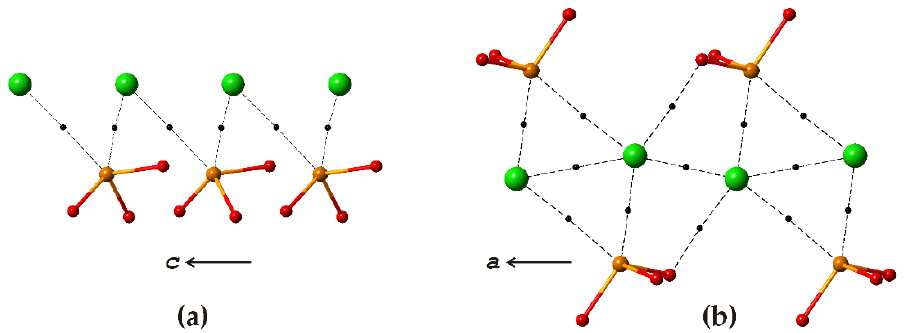
Figure 7. The arrangement of (SeO 3 ) groups and Cl atoms in the channels in the crystal structures of georgbokiite ( a ) and parageorgbokiite ( b ). Dashed lines indicate bond paths that correspond to weak closed-shell interactions. Legend as in Figure 5.